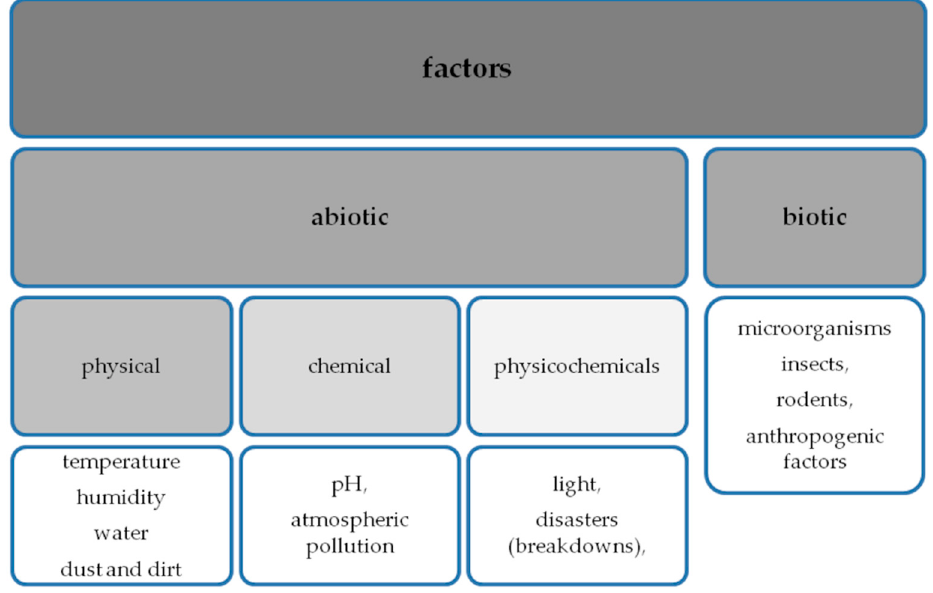
Figure 1. Factors that cause biodeterioration and can coexist and depend on each other [6].